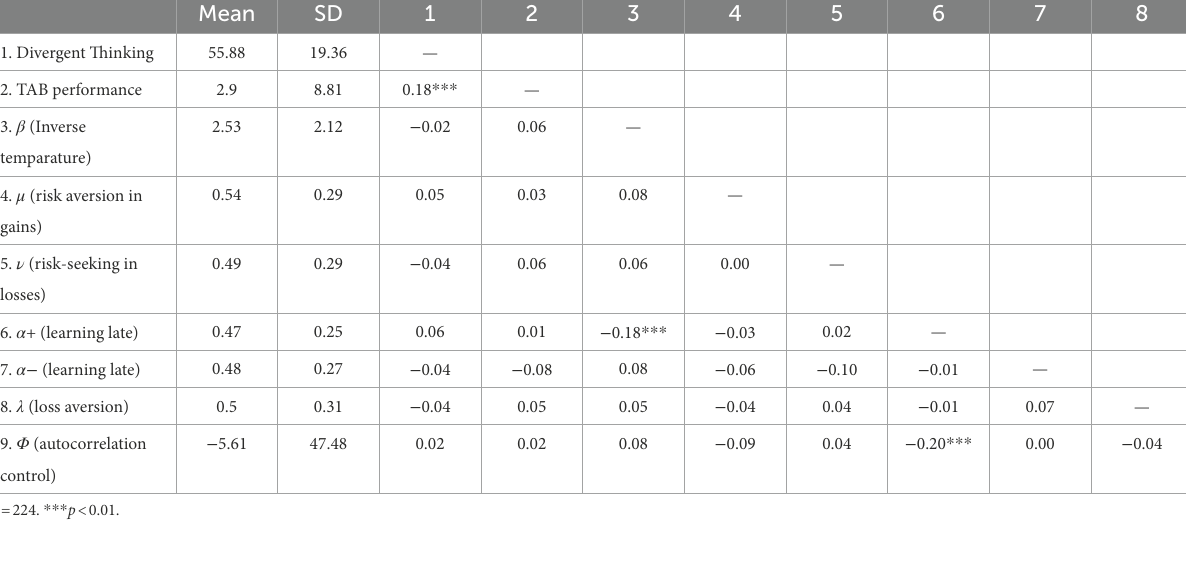
TABLE 1B Descriptive statistics